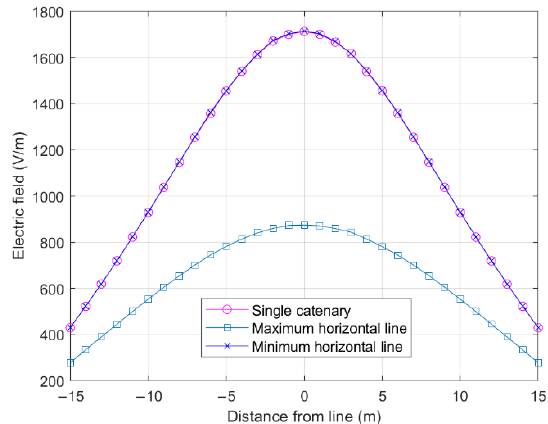
Figure 4. Comparison of the electric fields of horizontal and catenary lines.